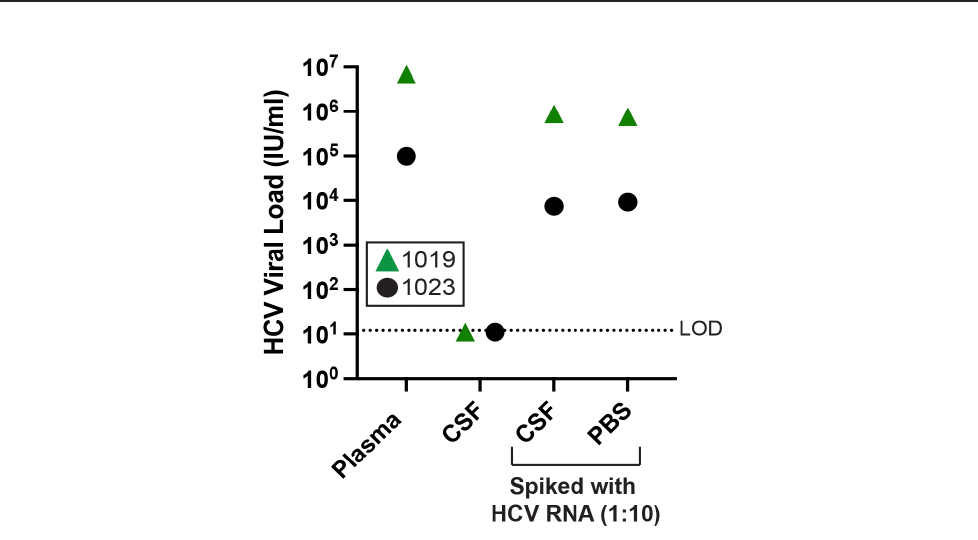
Figure 1. HIV-1 is actively trafficked into the CNS by infected cells. (A) Model of passive diffusion of virus into the CNS. (B) Model of virus trafficking into the CNS in infected cells. (C) HIV-1 has proportionally higher levels of virus in the CSF compared to HCV. The viral loads of HIV-1 and HCV in the blood and CSF are plotted as a ratio of CSF:Blood viral load for each of the 4 participants. Values for HIV-1 are shown in solid circles, for HCV in open circles. Because the HCV viral load was undetectable in the CSF, a value just below the ratio that would have been recorded at the limit of detection (LOD) is shown.